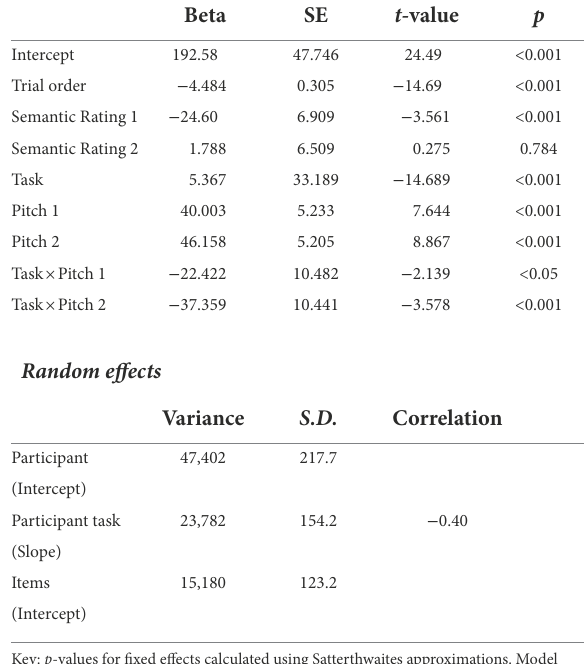
Key: p -values for fixed effects calculated using Satterthwaites approximations. Final Model equation: PupilSize ~ (1|Subject) + (1 + Noise|Item) + TrialOrder + Semantic Rating + (Noise × Pitch).